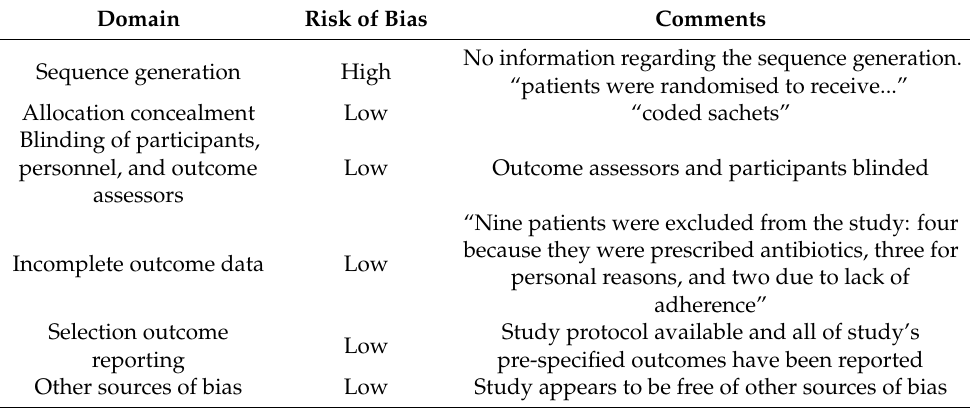
Table 6. Risk of bias of the randomized controlled trial—Garc í a-Peres et al., 2012